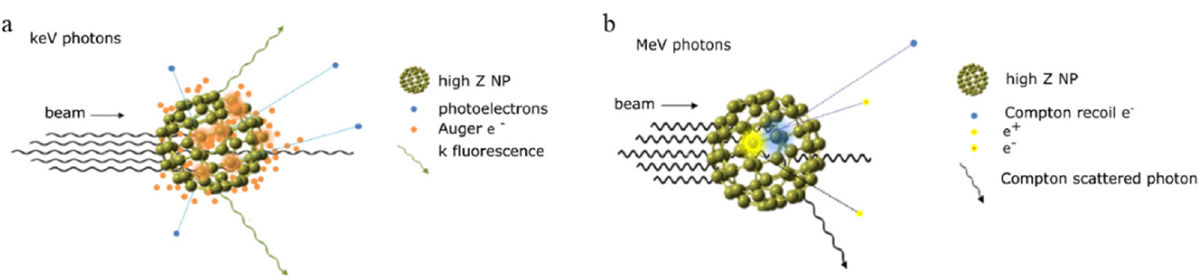
Figure 2. Schematic illustration of inelastic interactions with a high-Z nanoparticle for: ( a ) incident keV photons (orange clouds represent photoelectric events); ( b ) incident MeV photons (blue and yellow clouds represent Compton scatter and pair production events, respectively); Image reproduced with permission from Prof. Z. Kuncic and Dr. Y. Gholami from Phys. Med. Biol. 63 (2018) 02TR01 [77].